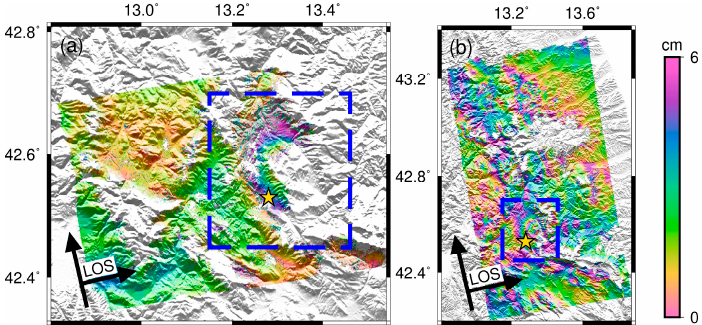
Figure 8. Coseismic interferograms of 18 January 2017 Campotosto earthquake obtained from the ascending Sentinel-1 track T117 ( a ), the ascending ALOS track P197 ( b ). The golden yellow star corresponds to the epicenter of 18 January 2017 Campotosto earthquake [12]. The interferograms are rewrapped with an interval of 6 cm. The blue rectangle outlines the study area.